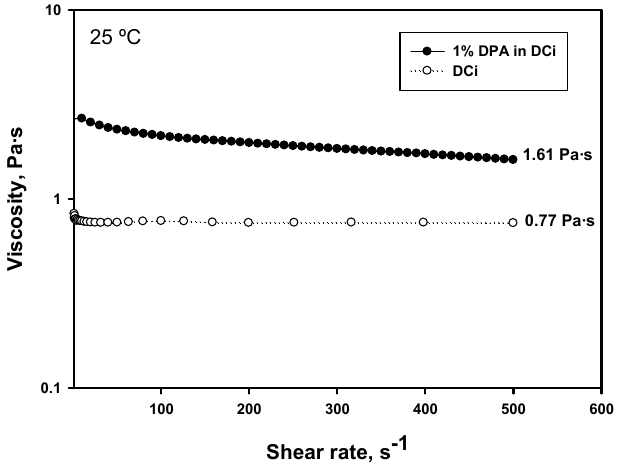
Figure 3. Viscosity variation with increasing shear rate for neat DCi and (DCi + DPA) at room temperature.